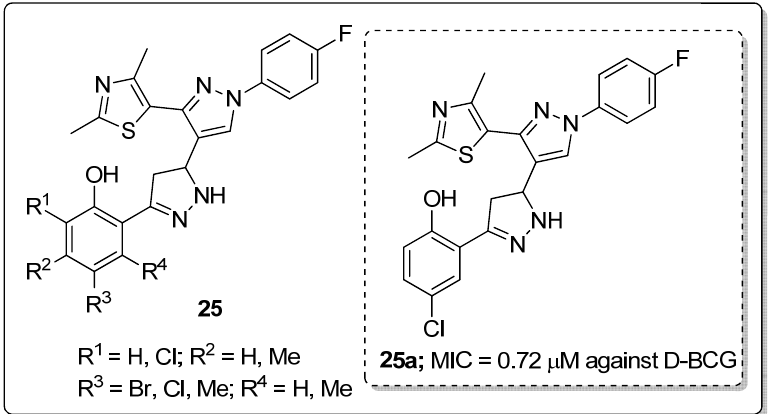
Figure 29. The antitubercular activity of the most active thiazole-pyrazole hybrid 25a .